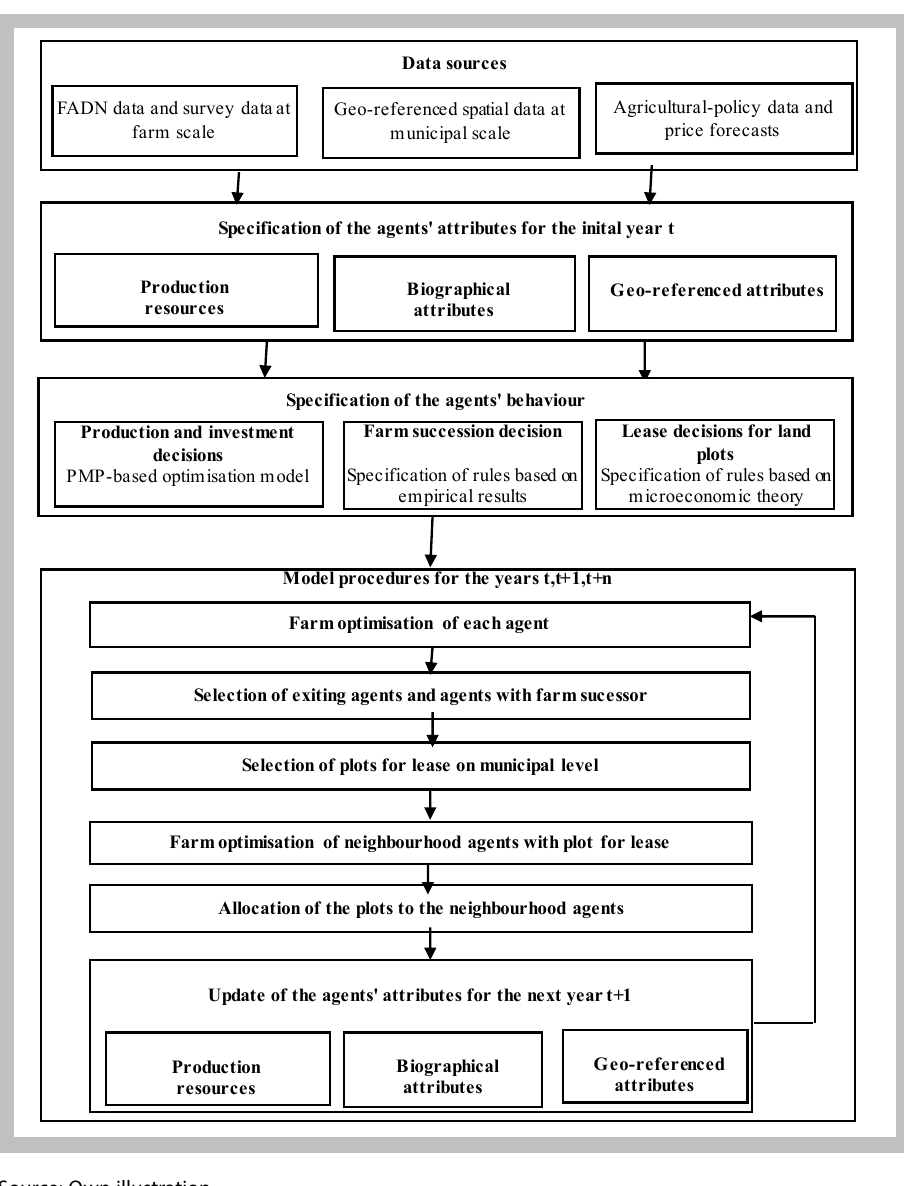
Figure 1. Schematic model overview of the agent-based sector model SWISSland.